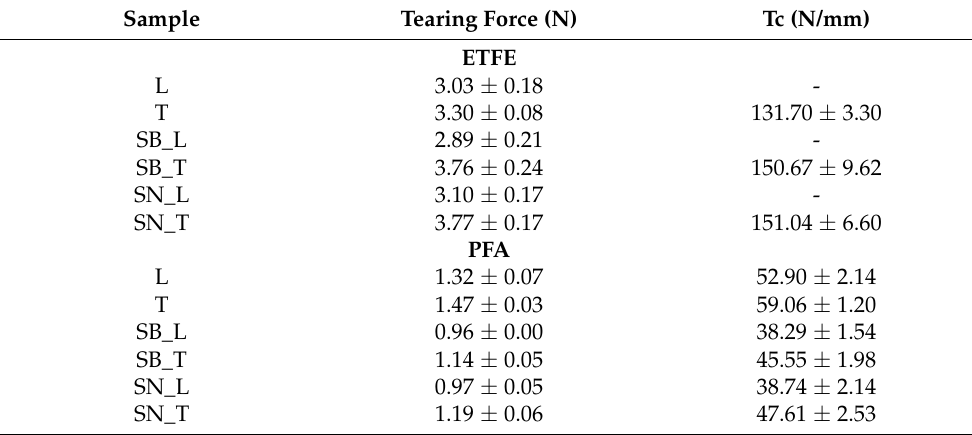
Table 5. Properties of the ETFE and PFA trouser tear test; mean values and standard deviations